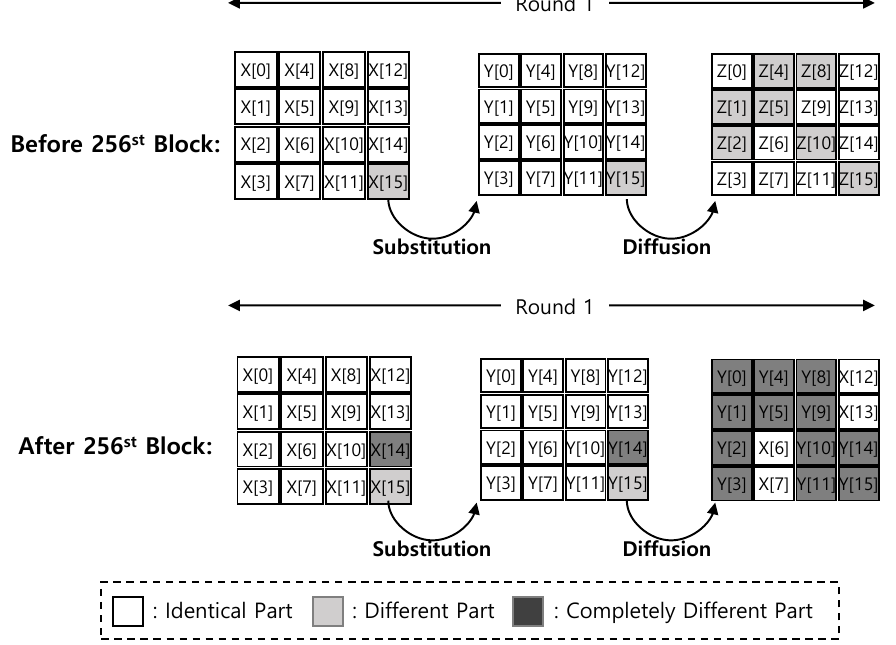
Figure 5. Difference between first and second blocks in Round 1 of ARIA-CTR mode of operation after 256th